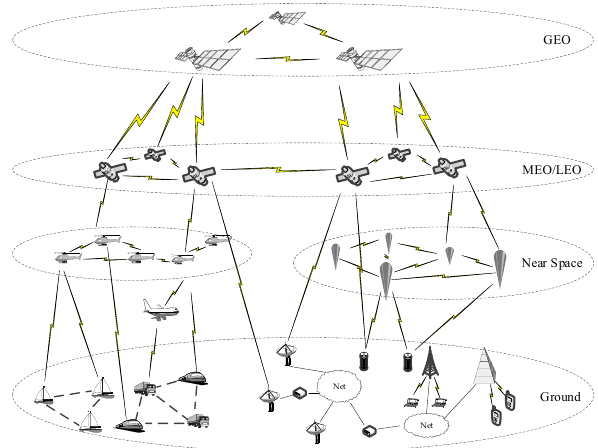
Figure 1. Composition and architecture of the Space Information Network (SIN) (adopted from Figure 1. C omposition and architecture of the Space Information Network ( SIN) ( adopted from S.Y. et al. [13] ) . S.Y. et al.